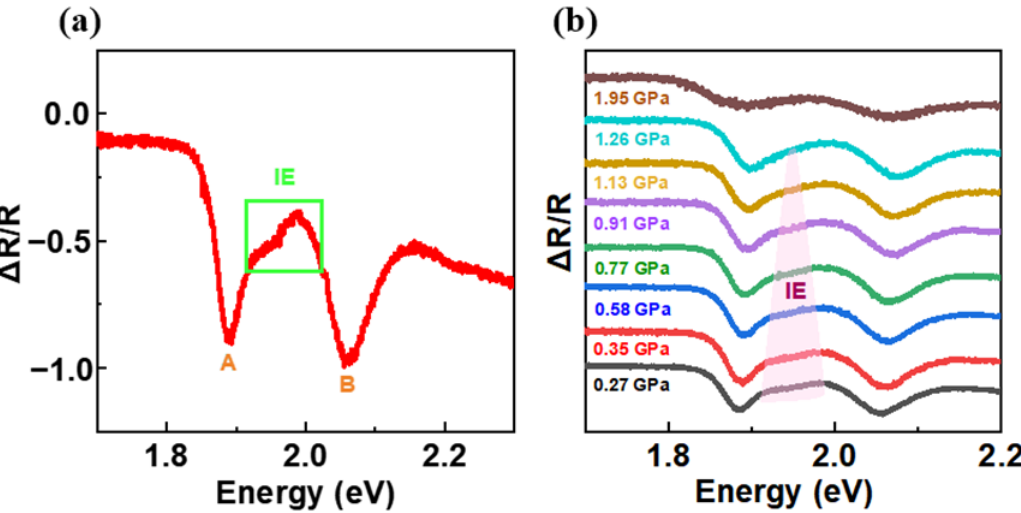
Figure 4. ( a ) The reflectivity spectrum of bilayer MoS 2 under ambient pressure. ( b ) Pressure-dependent reflectivity spectra of bilayer.